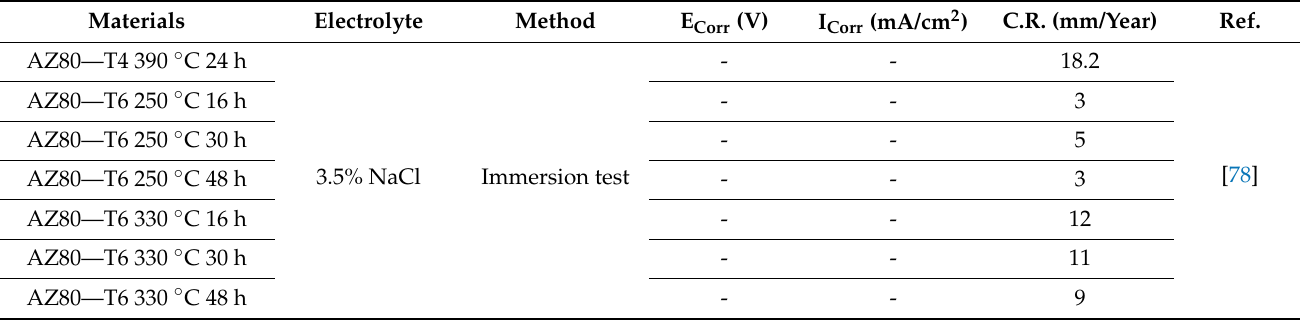
Table 2. Corrosion behaviour of AZXX Mg